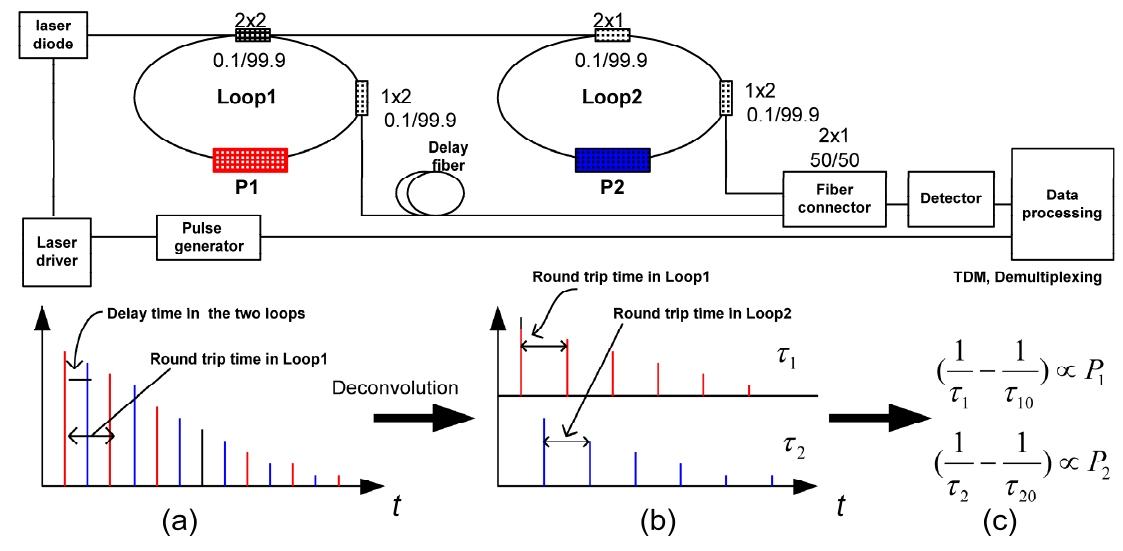
Figure 7. Proposed concept of the sensor platform in a serial configuration. A platform consisting of two sensor units is used to illustrate the concept. (a) Signals from the two sensor units are coupled; Red: from Loop1; blue: from Loop2. (b) Decoupled signals from determination of P1 and